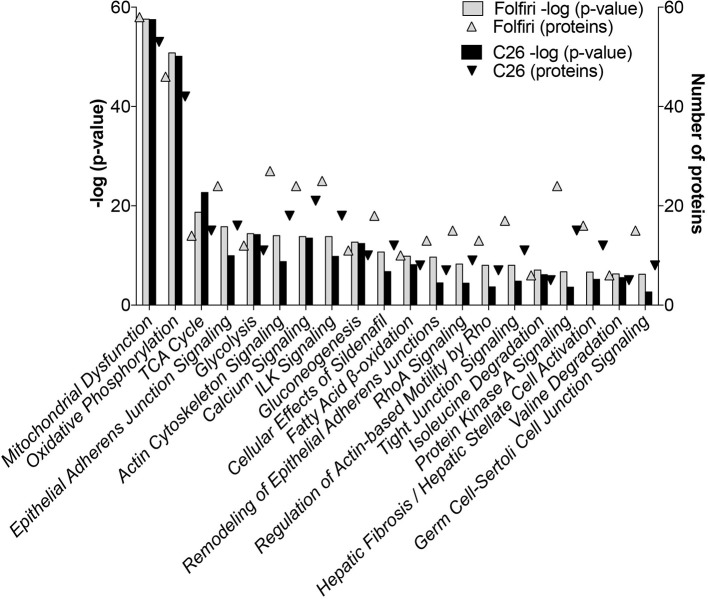
Pathway analysis of muscle proteomic profiling in cancer or chemotherapy-induced cachexia. By utilizing the IPA software, the C26 and Folfiri datasets were subjected to pathway analysis. The pathways were ranked based on their overlap p-value (bars). Top-20 pathways are reported in the diagram, along with the number of proteins modulated within each pathway (triangles).